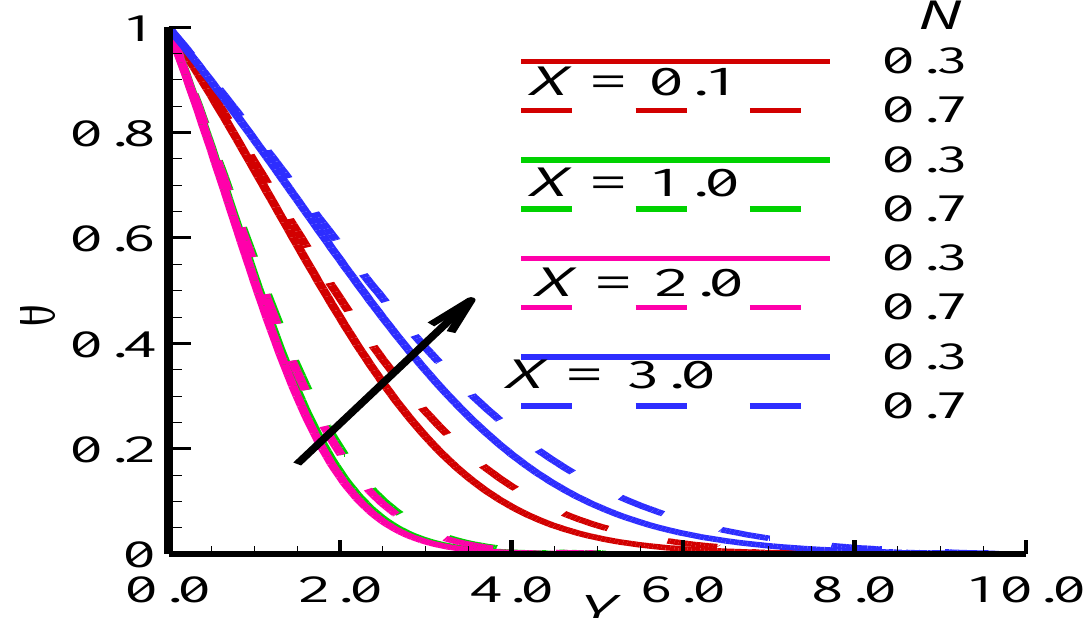
Figure3. Outcomes of radiation parameter 𝑁 on temperature distribution 𝜃 when 𝑁𝑏 = Figure 3. Outcomes of radiation parameter N on temperature distribution θ when Nb = 1.5, Nt = 1.5,𝑁𝑡 = 1.5,𝑃𝑟 = 7.0, and 𝑆𝑐 = 10.0 . 1.5, Pr = 7.0, and Sc =